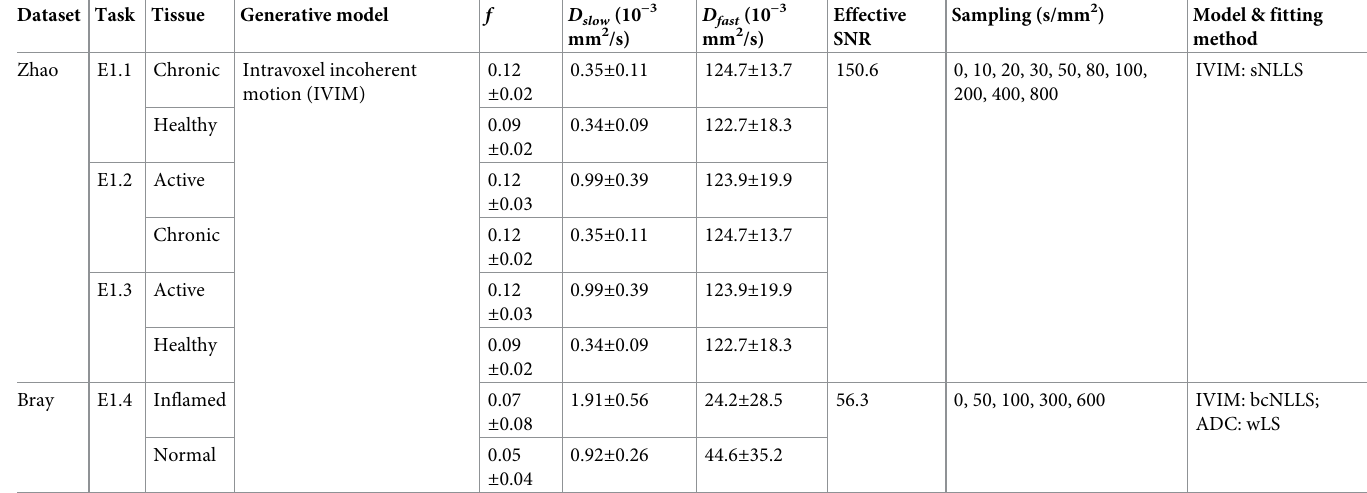
Table 1. Computational pipeline settings for E1. Synthetic signals were generated using parameters drawn from normal distributions taken from Zhao [38] or Bray [41]. Effective SNR for E1.4 was calculated from Bray’s b = 0 images, and, for Tasks E1.1-E1.3, adjusted by mean ROI size and acquisition differences (TE, voxel size, num- ber of repetitions, etc.) between Bray and Zhao’s experiments. In E1.4, ADC values were estimated from IVIM-synthesised